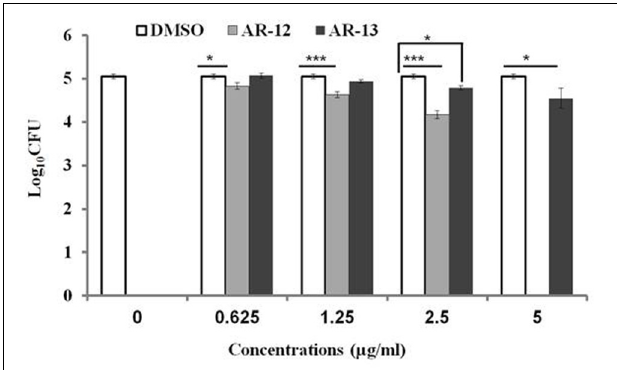
FIGURE 3 | Intracellular growth of LVS in hMDMs following AR-13 treatment. hMDMs (MOI = 50) were infected for 2 h, washed and treated with different concentrations of AR-13 or its related compound AR-12, which was previously shown to inhibit Francisella via induction of autophagy. Intracellular bacterial CFUs were determined by plating cell lysates at 22 h post-infection. A negative control was media containing (0.05% v/v) DMSO. The experiment was repeated three times with hMDMs from three different donors with similar results and the data from a representative experiment are presented as average ± SD. ∗ p ≤ 0.05, ∗∗∗ p ≤ 0.001, NS, not significant.